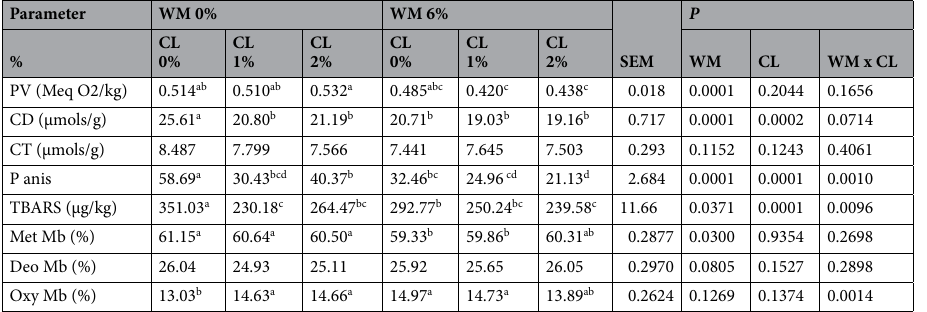
Table 6. Effect of WM and CL on oxidative stability of meat. Means within a row with no common superscript differ ( p < 0.05). PV Peroxide value, CD Conjugated dienes, CT Conjugated trienes, P anisidine Para anisidine, TBARS Thiobarbituric acid reactive substances, Met Mb Metmyoglobin, Deo Mb Deoximyoglobin, Oxi Mb